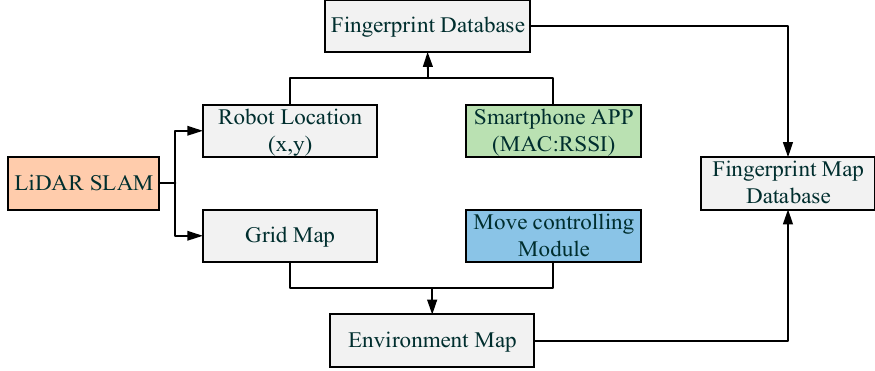
Figure 4. Workflow of the method.